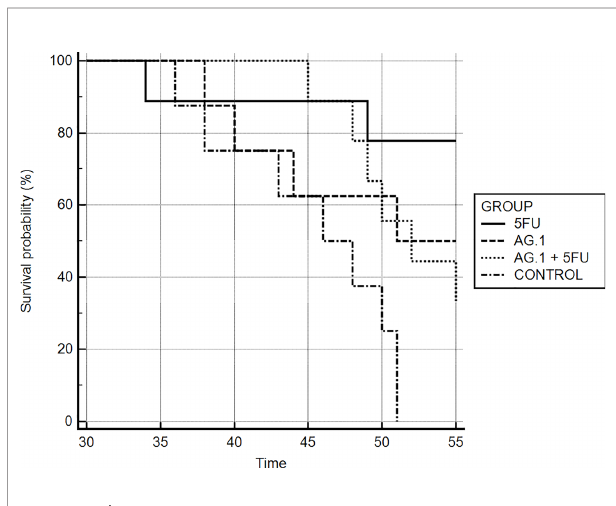
FIGURE 2 | Kaplan-Meier survival curves of mice bearing CT26.WT tumors in different treatment groups.